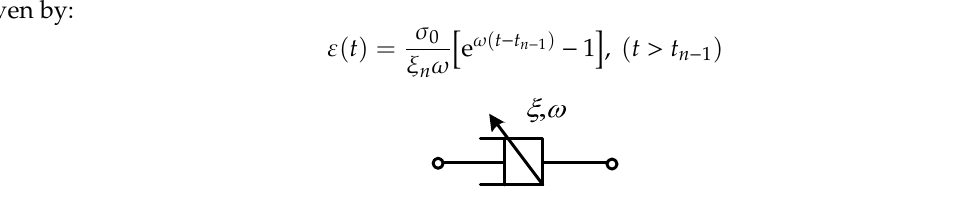
Figure 2. Dashpot element with time-varying viscosity.